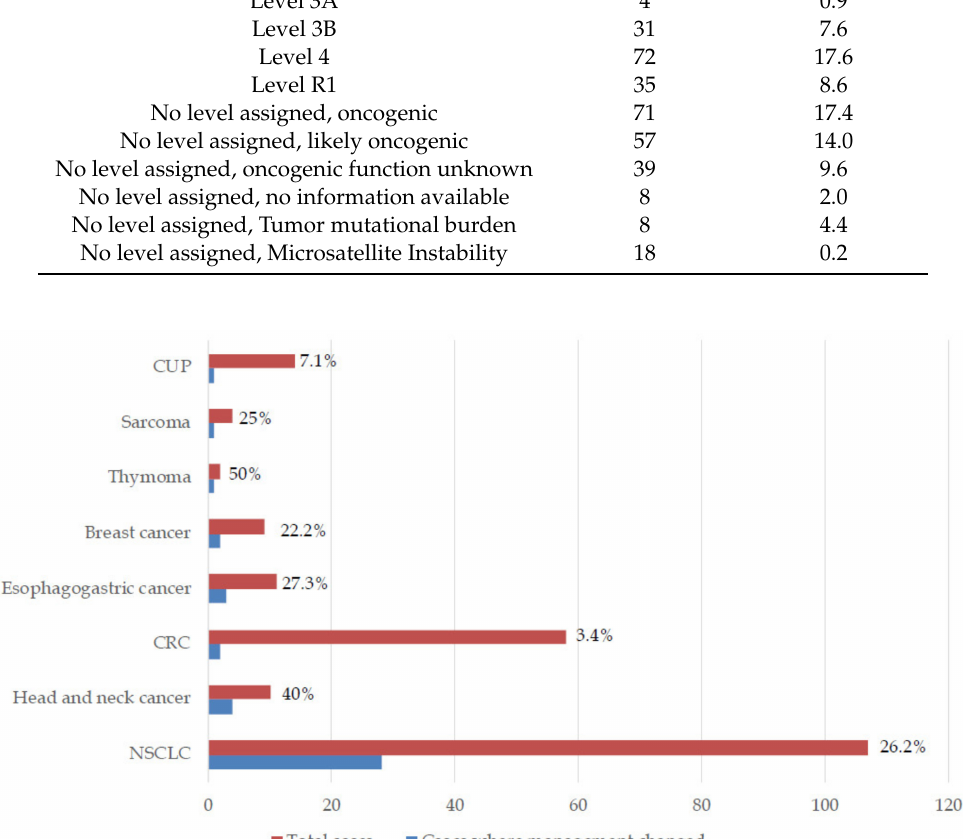
Figure1. Patientsinwhomcomprehensivegenomicprofilingchanged / potentiallychangedmanagement (NSCLC, Non-small cell lung cancer, CRC, Colorectal cancer, CUP, Carcinoma of unknown